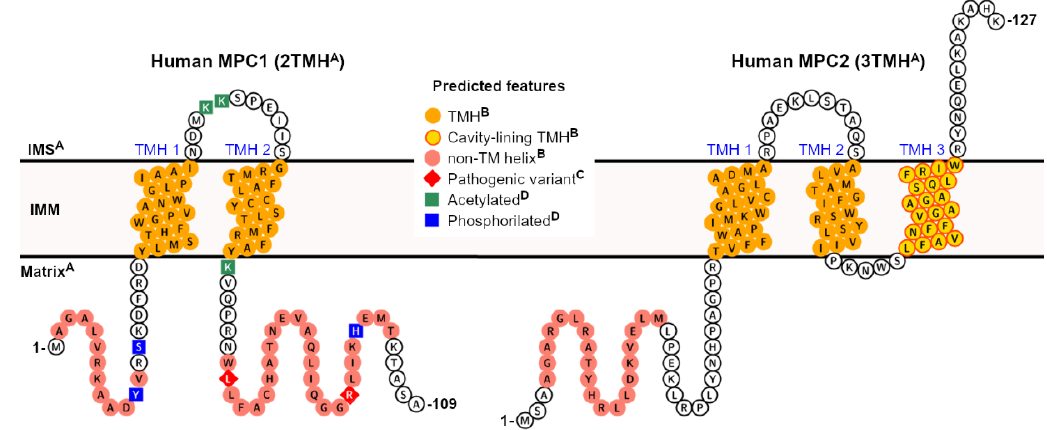
Figure 1. Predicted features of human mitochondrial pyruvate carrier (MPC). A collection of elements, from either direct or correlational pieces of evidence and in silico predictions, can be projected for the two human MPC subunits. A Correlational evidence: the topology and the orientation of each subunit within the IMM bilayer can be inferred from the experimental study on yeast MPC [25], based on significant primary sequence identity between homologs, particularly within the transmembrane helices; B computational prediction: the presence and positional boundaries of the TMH (orange circles) were predicted by the Constrained Consensus Topology server (CCTOP, [39]), and the non-TM helices (light red circles) by PSI-PRED workbench [40]. Of all five collective transmembrane helices in MPC1 and MPC2, only TMH 3 in MPC2 was predicted to contribute to cavity formation (yellow circles framed in red), according to MEMSAT-SVM [41,42]; C Experimental evidence: pathogenic variants (red diamonds) that severely compromise pyruvate transport activity have been described in patients [43], while still allowing for heterocomplex formation. For instance, mutations such as Leu79His and Arg97, have been described exclusively in MPC1, although at non-transmembrane regions [43]; D Experimental evidence: post-translational modifications, such as lysine acetylation (green squares), and phosphorylation (blue squares), have been identified exclusively in human MPC1, in a high-throughput proteomics study [44–46]. No signal peptides could be identified by primary sequence